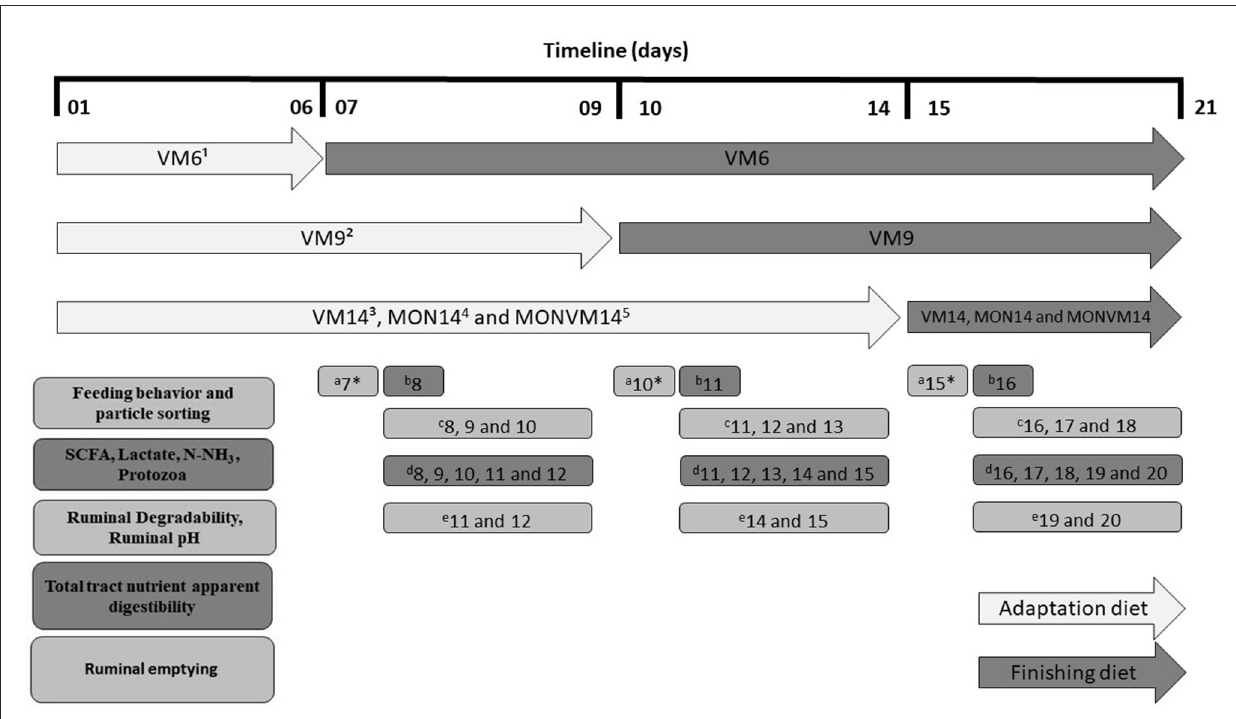
FIGURE1 Timeline of samples and data collection from Nellore steers cannulated in the rumen and fed Virginiamycin as sole feed additive in each experimental period. 1 VM6: 25mg of VM/kg of DM and adaption for 6 d; 2 VM9: 25mg of VM/kg of DM and adaption for 9 d; 3 VM14: 25mg of VM/kg of DM and adaption for 14 d; 4 MON14: 27mg of MON/kg of DM and adaption for 14 d; 5 MON + VM14: 27mg of MON/kg of DM and 25mg of VM/kg of DM and adaption for 14 d; a Feeding behavior and particle sorting; b Short chain fatty acids, lactate, N-NH 3 and Protozoa; c Ruminal degradability and Ruminal pH; d Total tract nutrient apparent digestibility; e Ruminal emptying. * Sampling was performed at days 7 to 12 for animals fed VM6 only (6-d adaptation); days 10 to 15 for animals fed VM9 only (9-d adaptation); days 15 to 16 for all animals (VM14, MON14, and